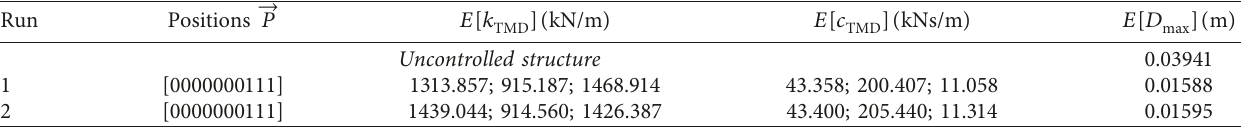
Table 2: Robust design of MTMD.